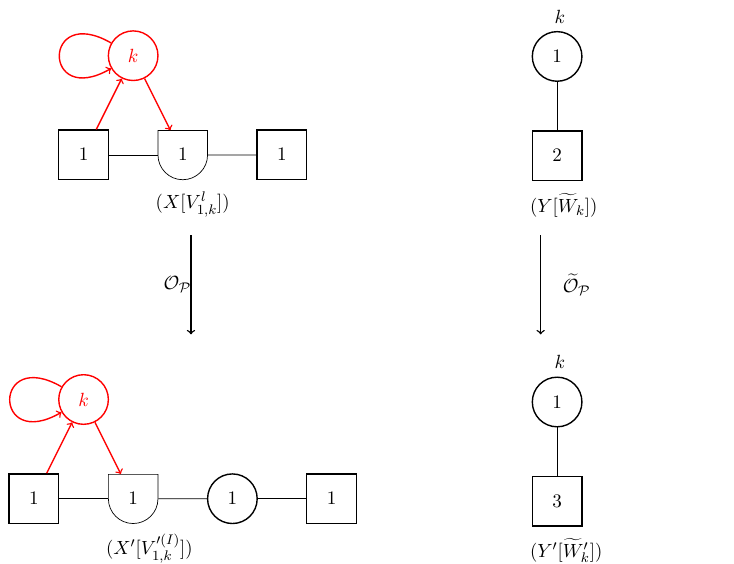
Figure 23 . The construction of a vortex defect and its dual Wilson defect, using a flavoring-gauging operation, with a pair of defects in T (U(2)) as a starting